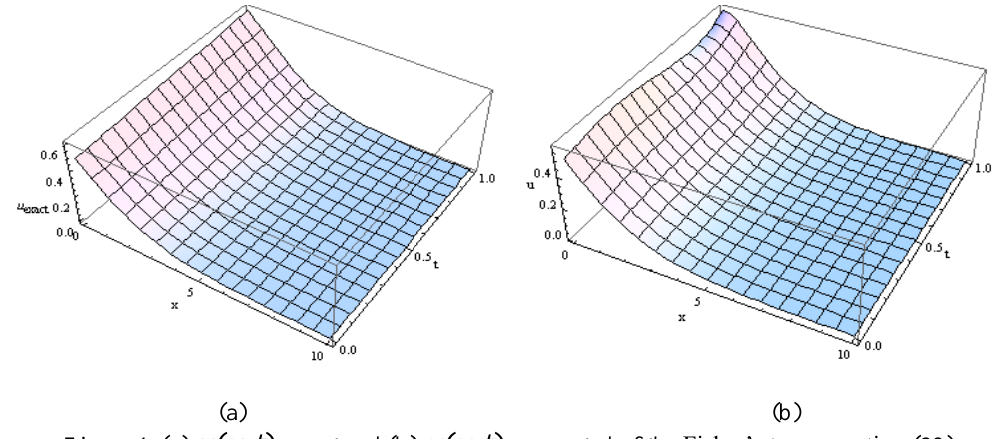
(a) (b) Figure 4. (a) ) , ( t x u exact and (b) ) , ( t x u computed of the Fisher’s type equation